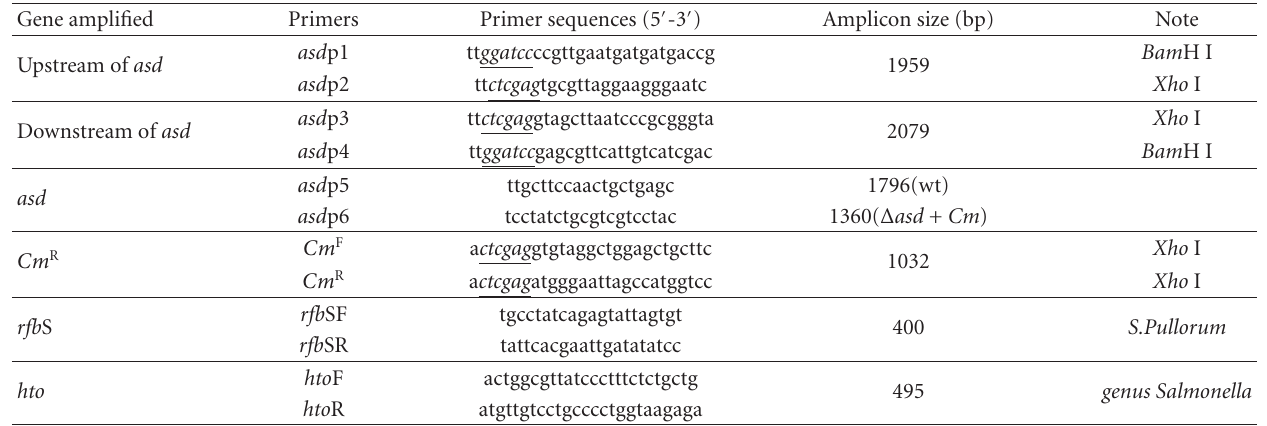
Table 2: The primer sequences used for PCR